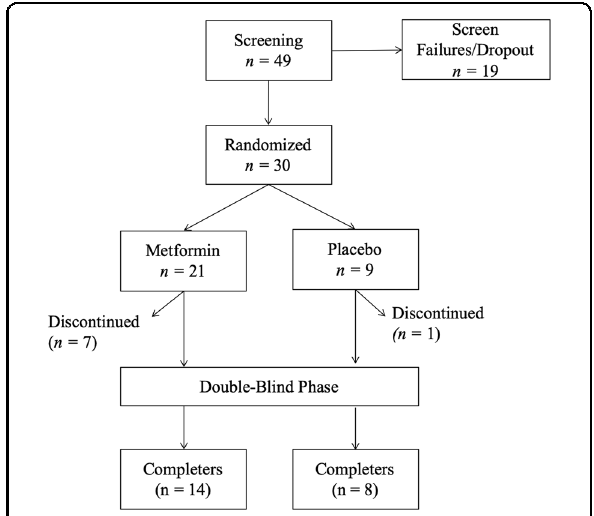
Fig. 1 Flowchart of study participants. All participants who were randomized and had received at least 1 dose of metformin or placebo were included in the